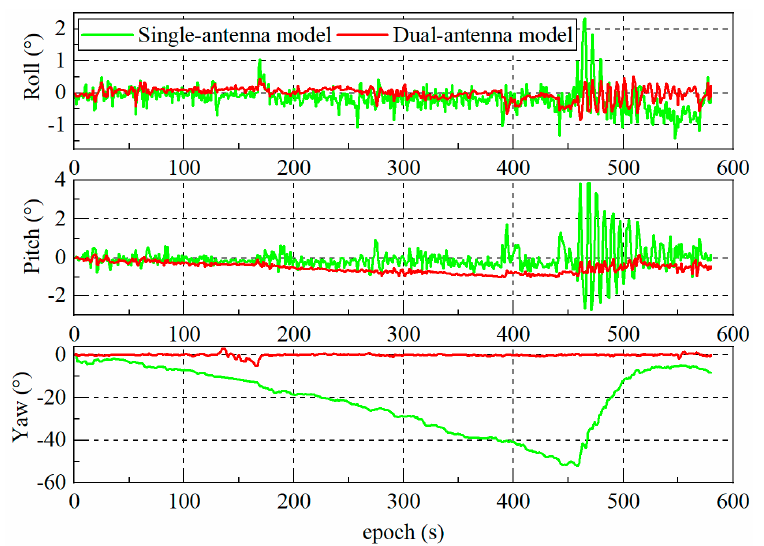
Figure 7. Attitude angle error of dual-system (GPS + BDS) GNSS/MIMU tightly coupled integration using the EKF in single ‐ antenna mode and dual ‐ antenna mode.